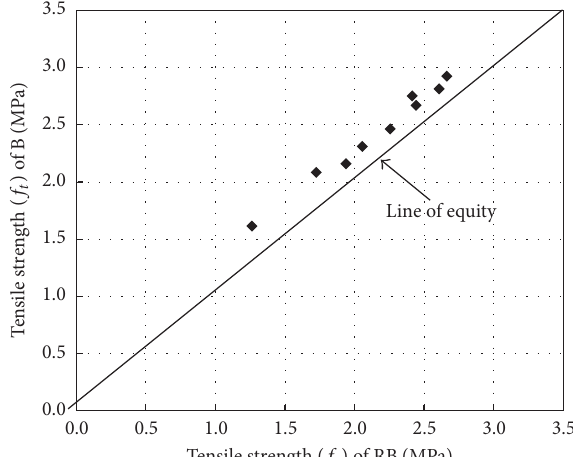
Figure 6: Compressive strength of concrete.